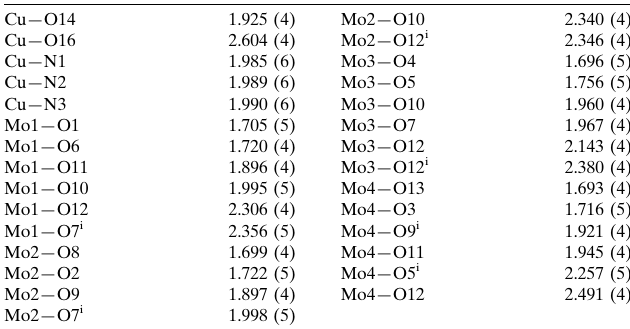
Selected bond lengths (A˚ ).